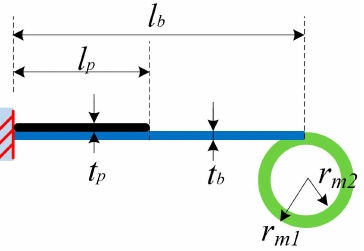
Figure 6. Dimensions of the beam structure and the ring mass (not in scale).